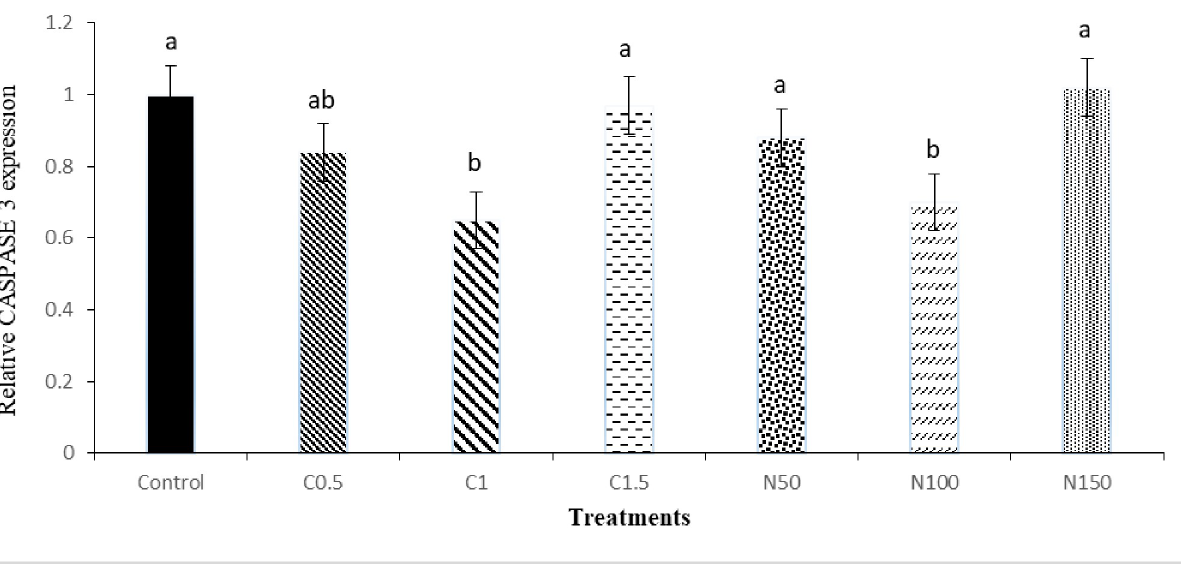
Fig 8. Relative mRNA expression of CASPASE 3 gene in the rooster sperm cryopreservation supplemented with crocin and naringenin. Beltsville extender without antioxidant (control), C0.5 (Beltsville extender with 0.5 mM crocin), C1 (Beltsville extender with 1 mM crocin), C1.5 (Beltsville extender with 1.5 mM crocin), N50 (Beltsville extender with 50 μ M naringenin), N100 (Beltsville extender with 100 μ M naringenin), N150 (Beltsville extender with 150 μ M